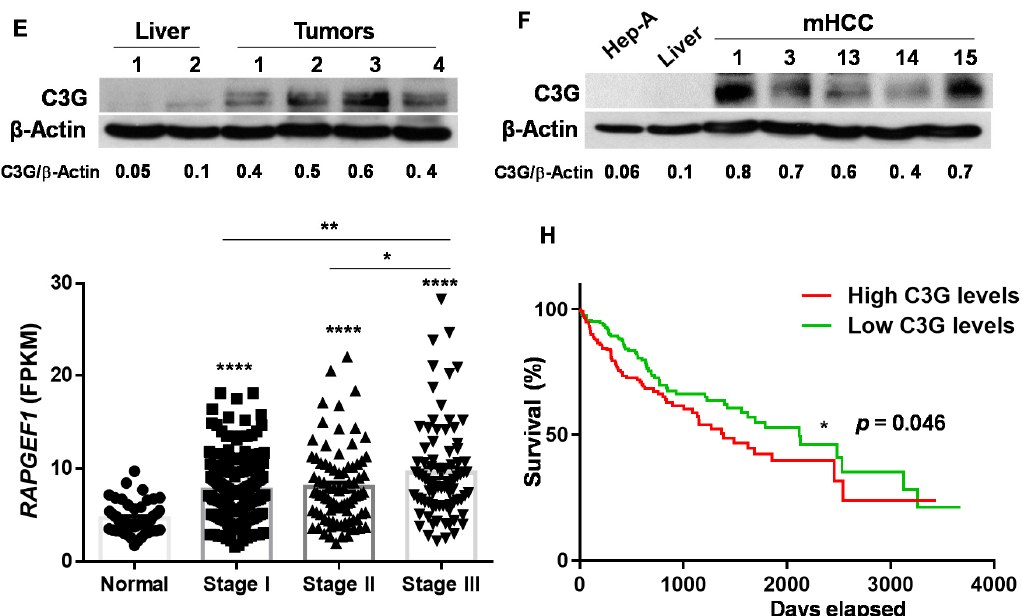
Figure 1. C3G expression is increased in HCC. ( A and B ) Western-blot analysis of C3G levels normalized with β -actin: ( A ) in neonatal hepatocytes (Hep-N), adult hepatocytes (Hep-A), oval cells (Oval C) and HCC cell lines (Hep3B and HLE) ( n = 4); and ( B ) in a panel of human HCC cell lines ( n = 2). ( C ) C3G mRNA levels in human HCC cell lines determined by RT-qPCR. RQ values are relative to Hep3B cells ( n = 3). ( D ) Upper panels: representative images of C3G levels analyzed by immunochemistry in liver sections from control (no treatment) and DEN-treated mice at 9 months after treatment; lower panel: box plot showing the mean ± S.E.M. of C3G positive areas, analyzed by ImageJ. Negative control was incubated only with a secondary antibody. * p ≤ 0.05, using Student’s t -test, control vs. DEN-treated ( n = 4–7). ( E , F ) Western-blot analysis of C3G protein levels normalized with β -actin in: ( E ) control healthy liver and Alb-R26 Met tumors (1, 2, 3, 4); ( F ) adult hepatocytes (Hep-A), control healthy liver, and HCC cells established from Alb-R26 Met HCC tumors (mHCC1, 3, 13, 14, and 15) ( n = 3). ( G ) Scatter plot with bars shows mean ± S.E.M. of C3G ( RapGEF1) mRNA levels in FPKM units (fragments per kilobase of exon model per million reads mapped) in normal healthy liver samples (50) and in HCC corresponding to different stages of disease progression: stage I (176 patients), stage II (84 patients), and stage III (83 patients). * p ≤ 0.05, ** p ≤ 0.01, **** p ≤ 0.0001, analyzed by Kruskal–Wallis followed by FDR, vs. normal samples or as indicated. ( H ) Kaplan–Meier survival curve shows patient survival (as percentage) vs. the days elapsed of two groups of HCC patients, according to high or low C3G mRNA levels. * p ≤ 0.05, using Log-Rank Mantel–Cox survival analysis.